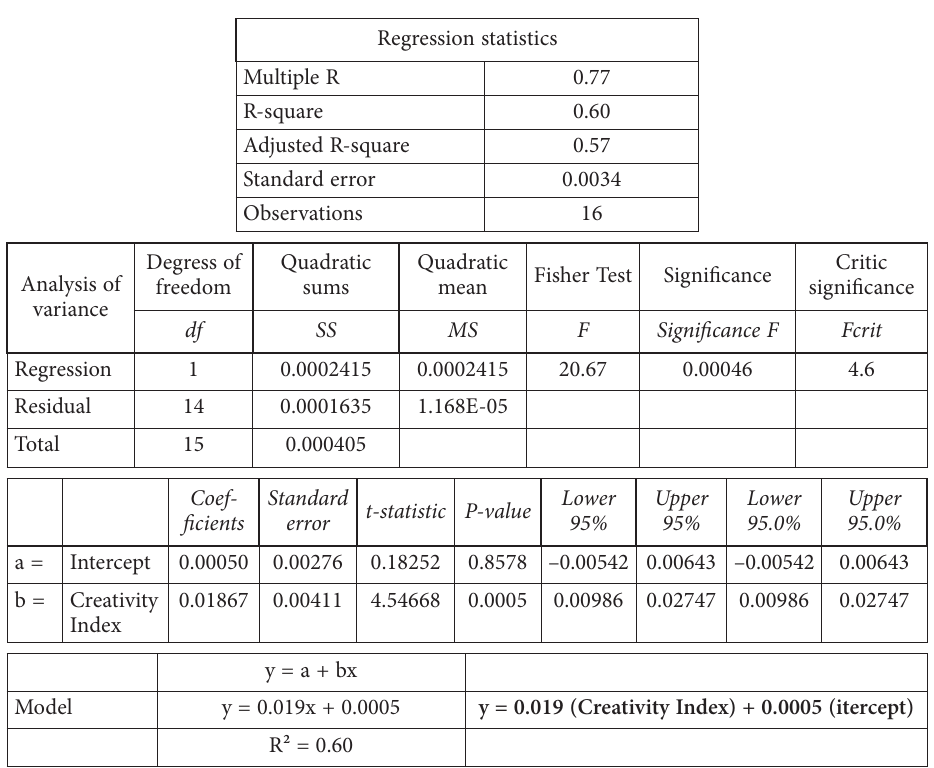
Table 3. Regression statistics, analysis of variance, relations between a and b and the model (source: created by